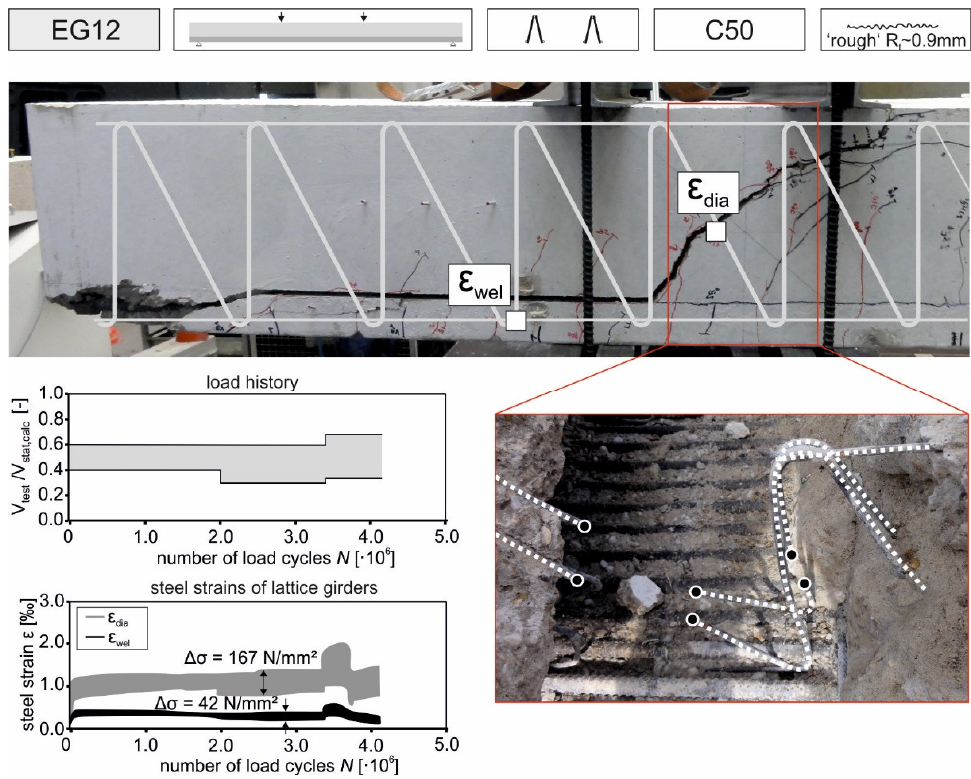
Figure 19. Influence of steel strains: load history, strain measurements of lattice girder, and fractured lattice girder for Specimen EG12.